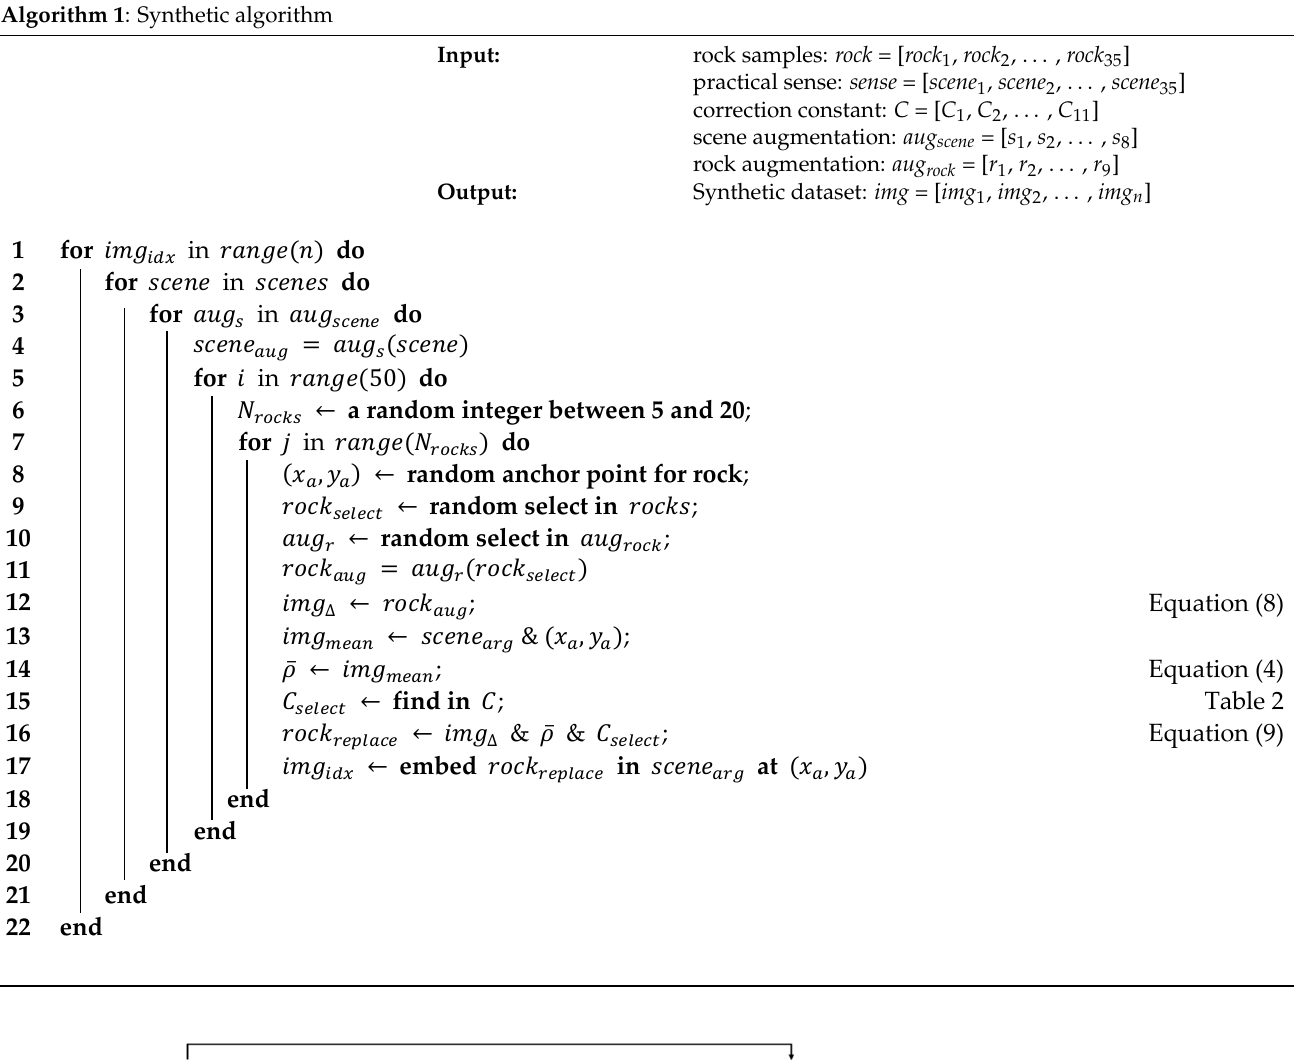
Algorithm 1 : Synthetic algorithm